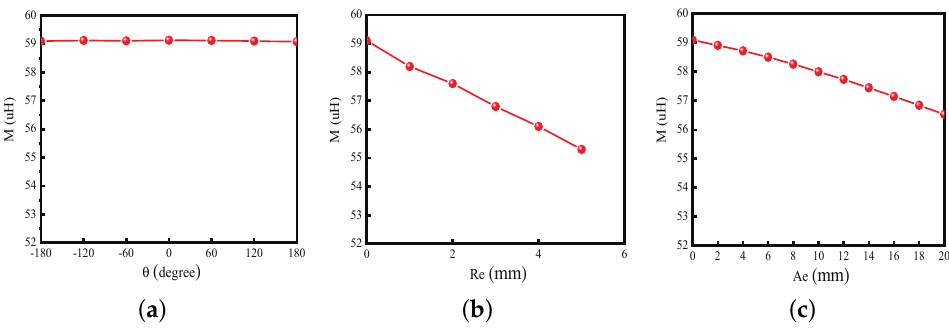
Figure 7. The variation curve of mutual inductance with misalignments. ( a ) Rotational misalignment. ( b ) Radial eccentricity. ( c ) Axial eccentricity.